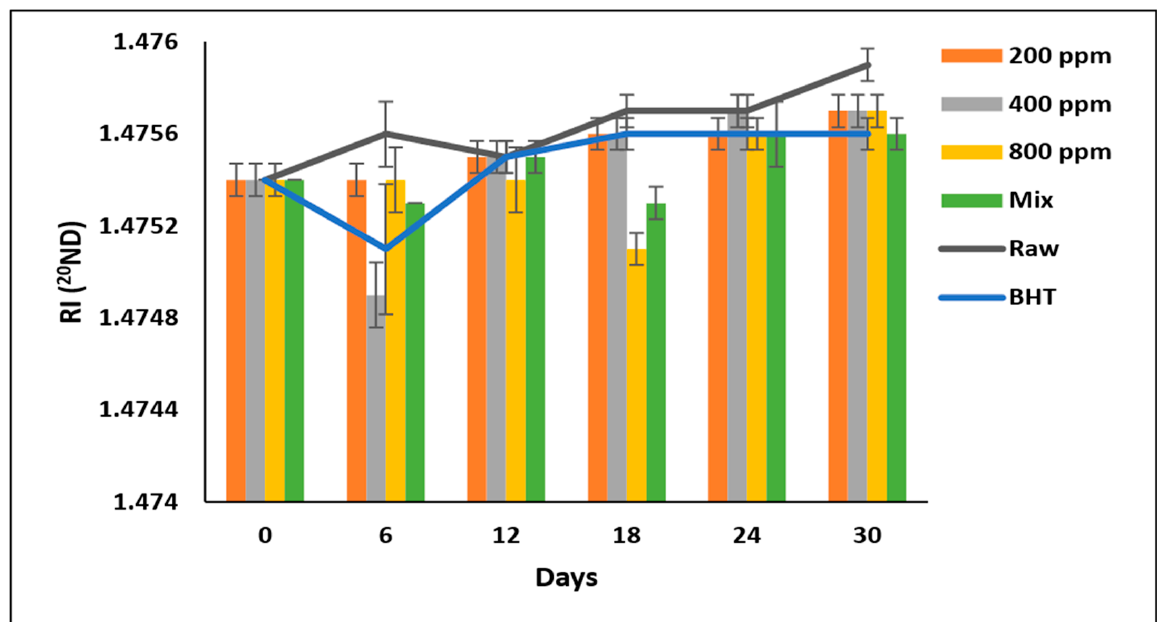
Figure 8. Refractive index (RI) of raw soybean oil (without antioxidants) and soybean oil enriched with PGG leaves extract (200, 400, and 800 ppm), BHT (200 ppm), and a PGG/BHT mixture (400/100 ppm) during the accelerated storage days (30 days) at 65 °C. * RI measured at 20 °C and using light with a wavelength of the sodium D line (589.29 nm) and expressed in ( 20 ND)